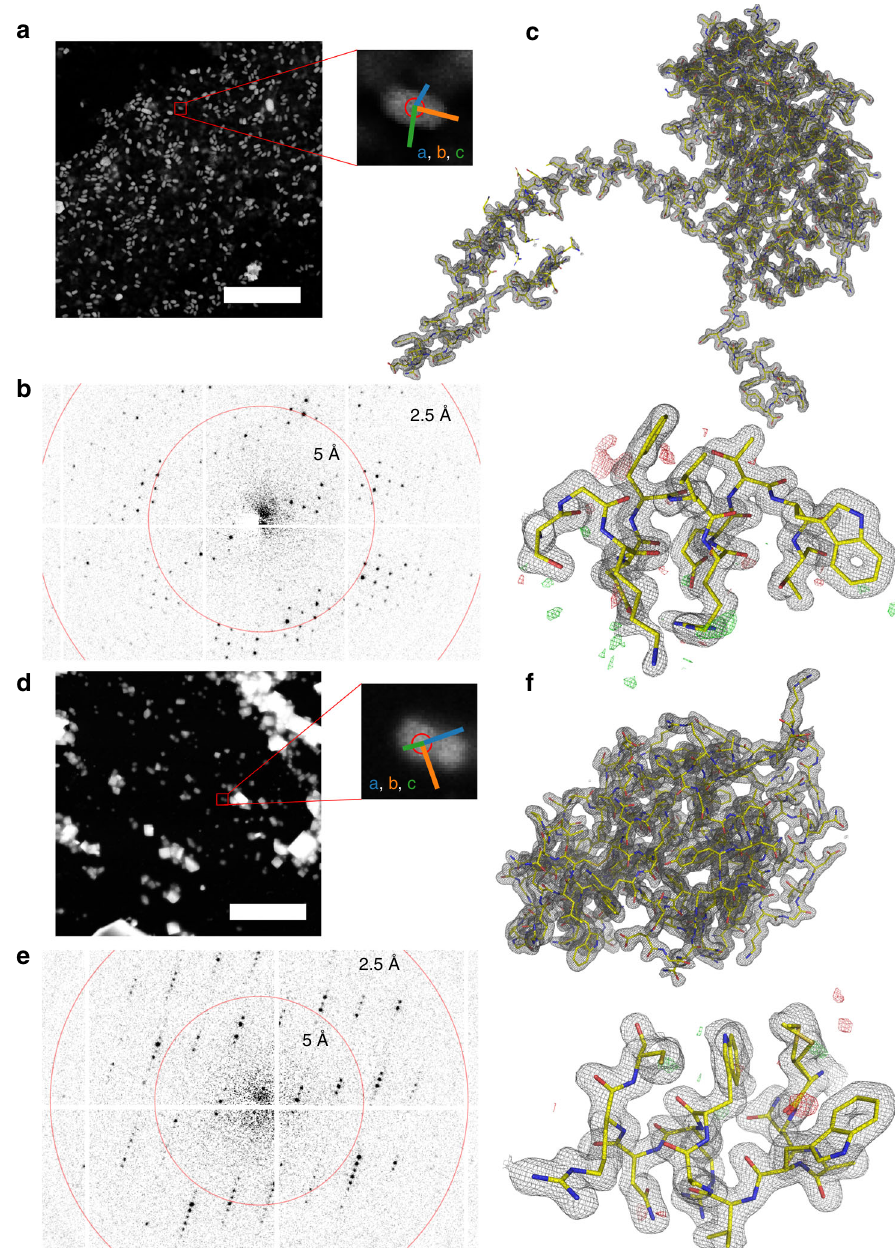
Fig. 2 SerialED results for granulovirus occlusion bodies and lysozyme. a STEM mapping image of a grid section containing granuloviruses, visible as bright features (scale bar is 5 μ m). A zoomed view of a representative virus is shown, where the red circle corresponds to the diffraction nanobeam diameter of ≈ 110 nm. Colored lines indicate the lattice vectors found after indexing of the diffraction pattern. b Diffraction pattern acquired from the features shown in a . c Obtained structures of granulin; 2F o − F c map of the entire structure, and zoom into a randomly chosen region, with F o − F c map overlaid. The maps are at 1.55Å resolution and contoured at ±1 σ and ±3 σ , respectively. d – f Analogous for lysozyme nanocrystals; maps are at 1.8 Å